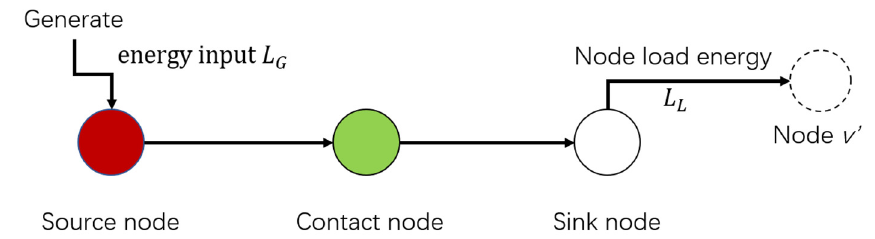
Figure 5. Node classification. Figure 5. Node